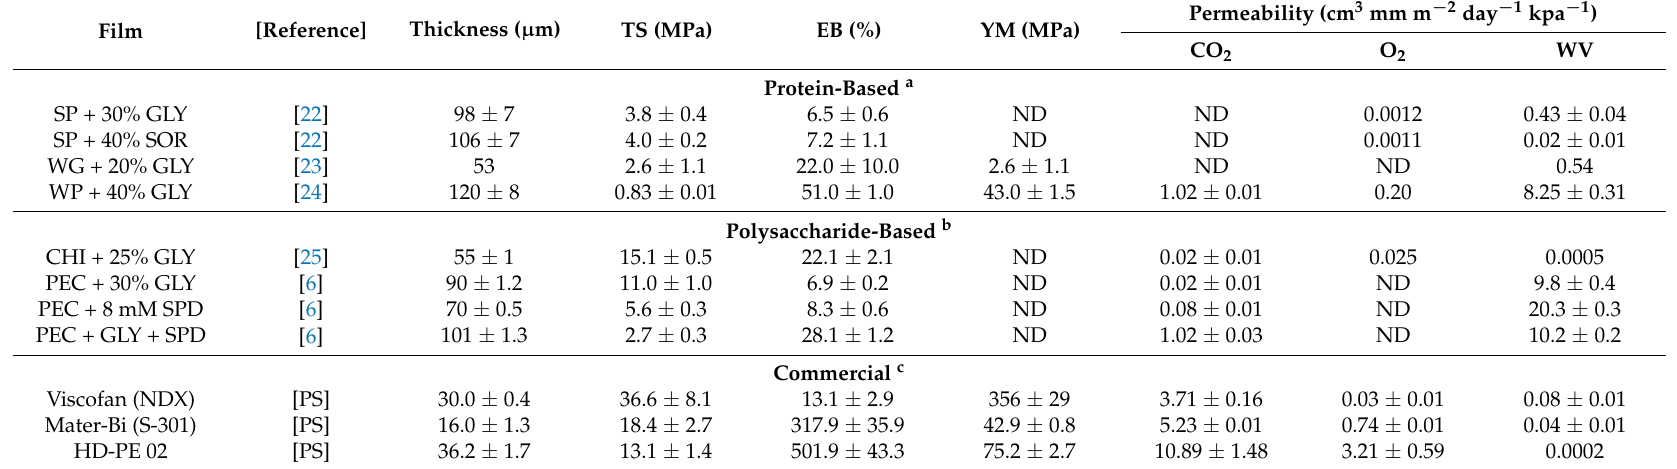
Table 7. Thickness, mechanical, and barrier properties of some commercial materials and of different protein- and polysaccharide-based films described in the